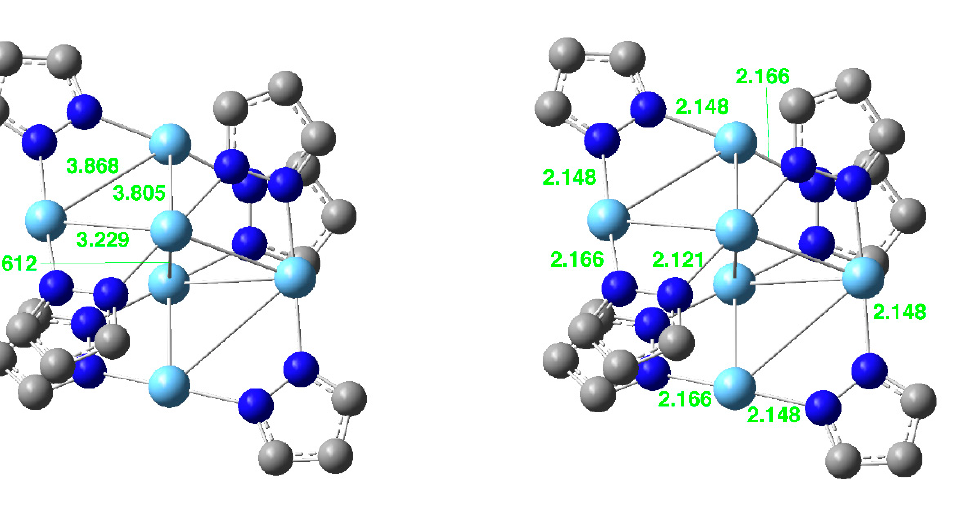
Figure 16. Optimized structures of Ag(I) pyrazolates.